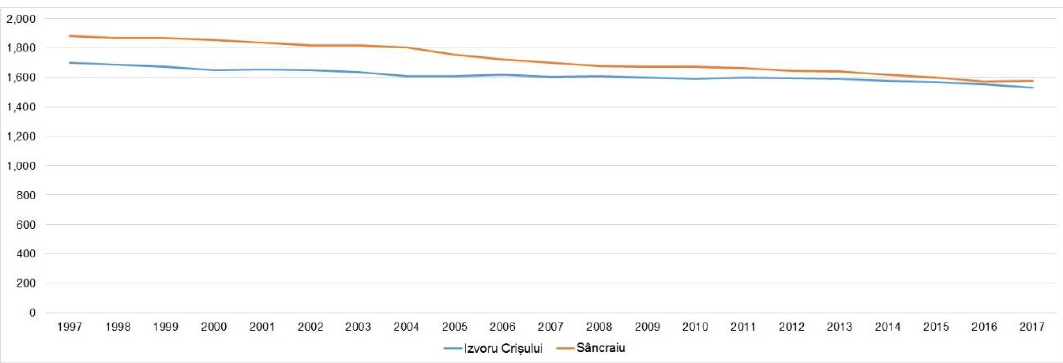
Figure 2: Number of inhabitants in the research areas